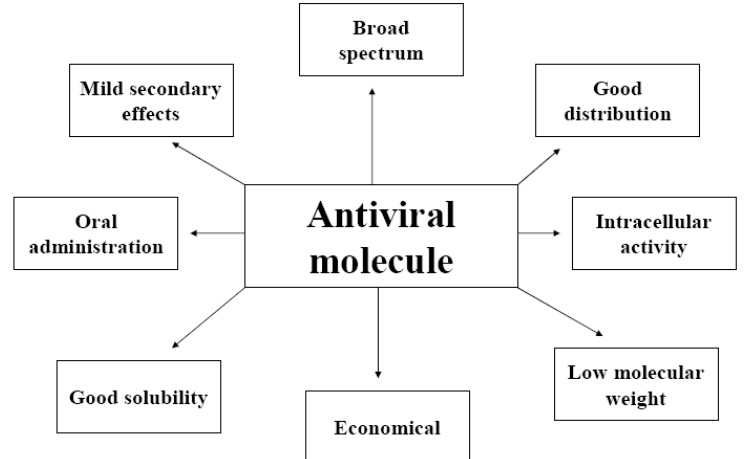
Figure 1. Principal characteristics of a perfect antiviral